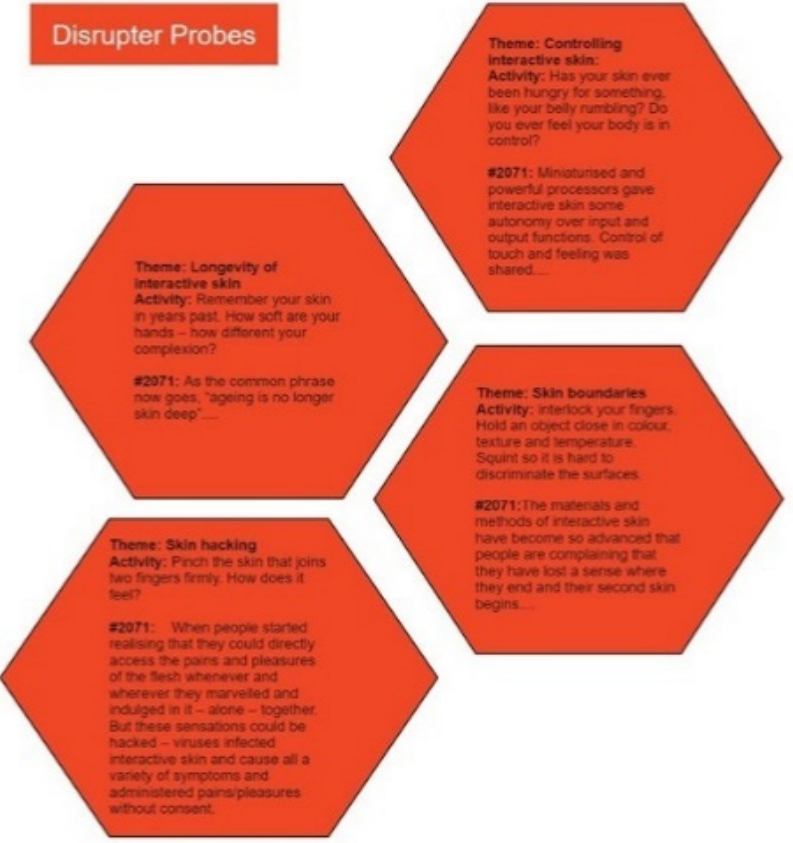
Figure 4. Examples of Disrupter Probes ‘dropped’ on the grid-board.